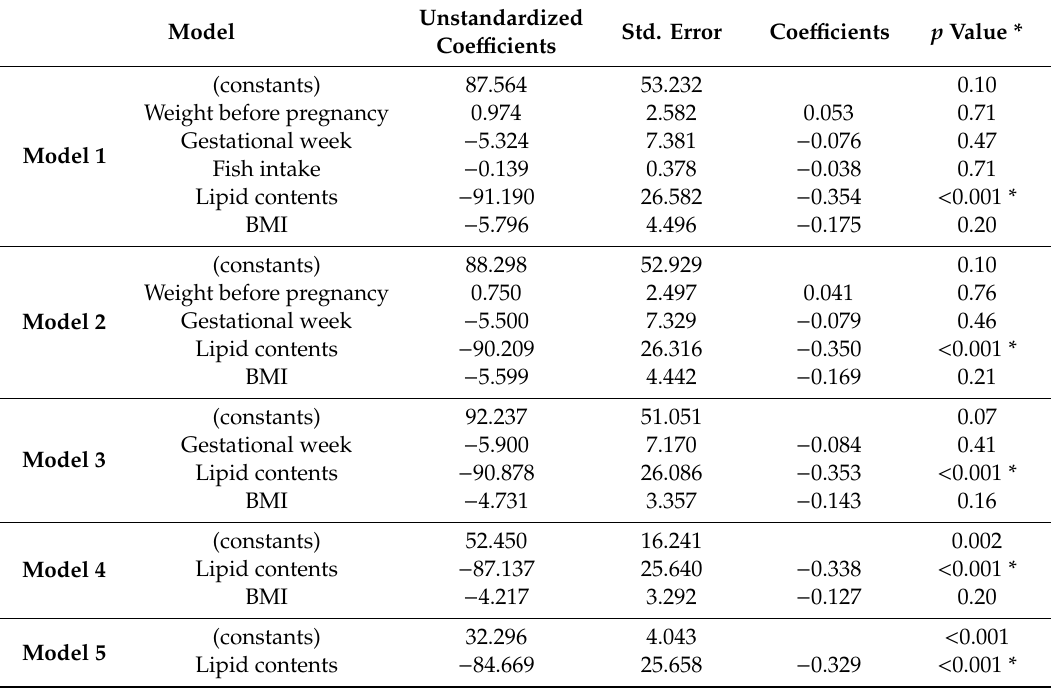
Table 5. Multiple regression analysis of OCS level.